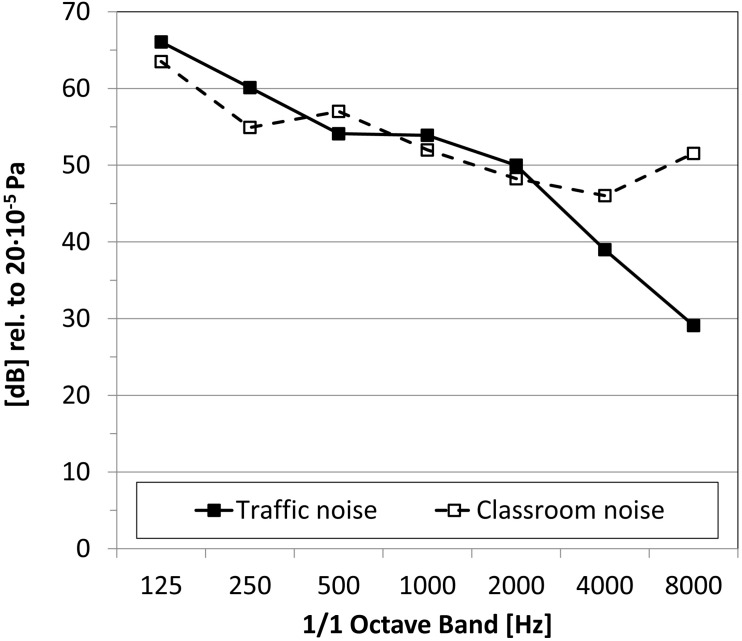
Octave band, long-term average spectra of background noises. The overall A-weighted level is set to 60 dB(A).